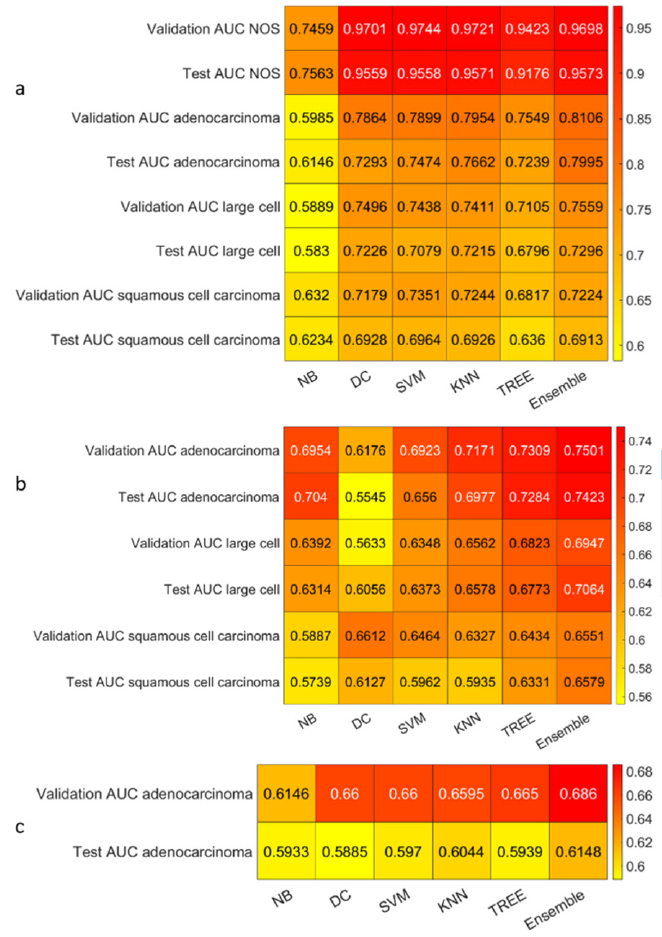
Figure 13. AUC heatmaps for the harmonized datasets: ( a ) The 4-classes datasets, ( b ) 3-classes datasets, and ( c ) 2-classes datasets.